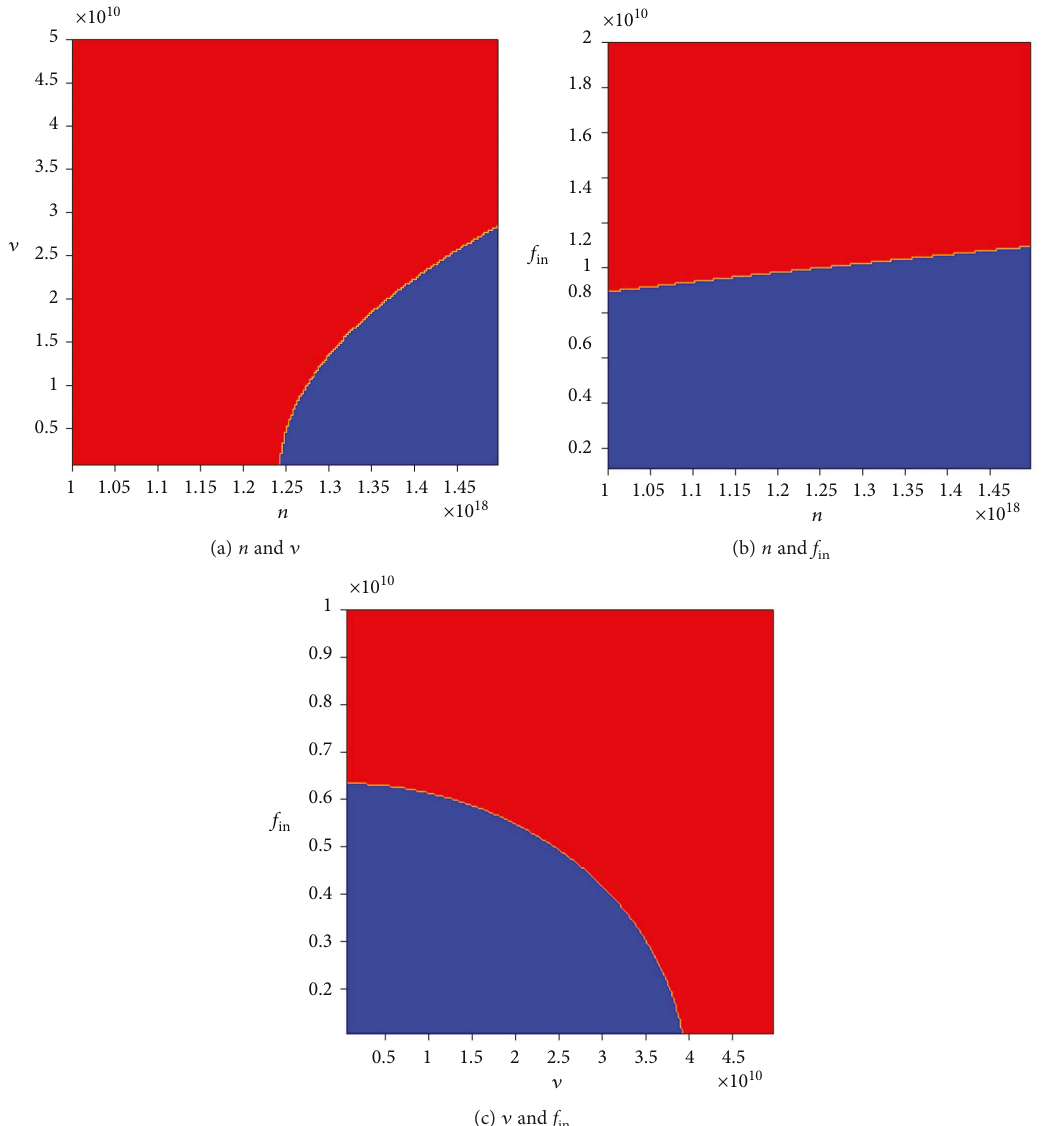
Figure 21: Behavior shift for the plasma dielectric permittivity as a function of the local plasma density n , the plasma collision frequency ν , and the incident wave frequency f